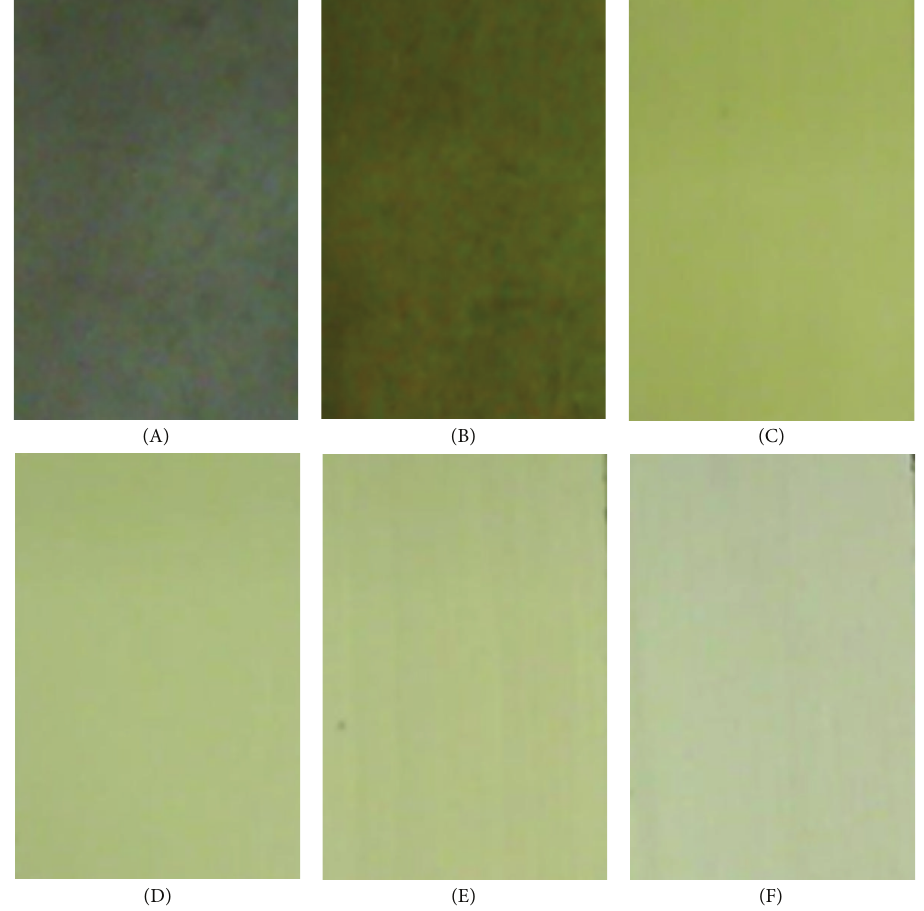
Figure 2: Samples of LC coated with TOP for outdoor exposure